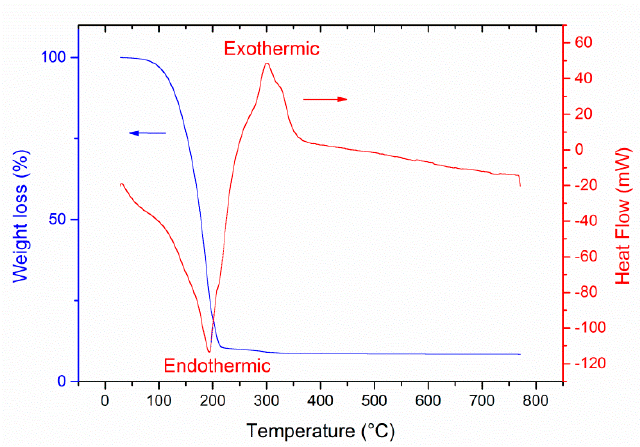
Figure 1. TGA/DSC thermograms of SnO 2.